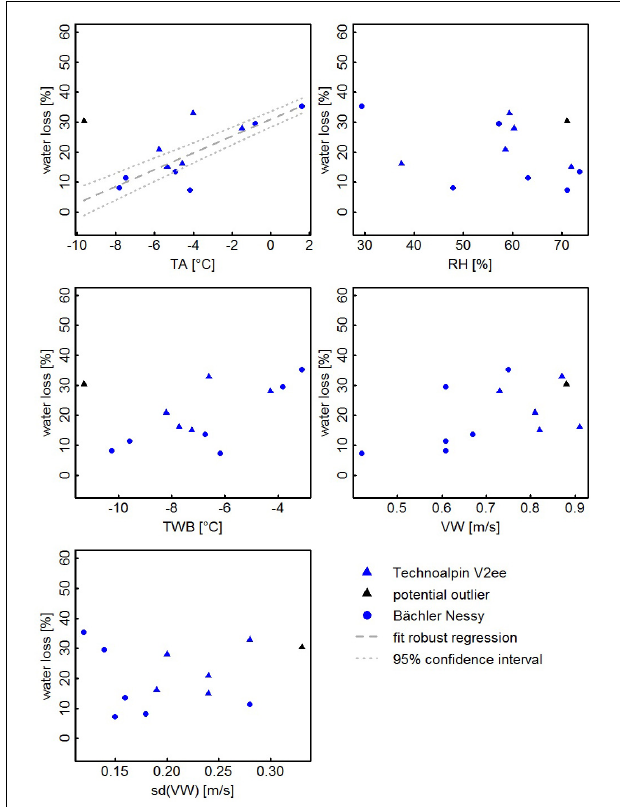
FIGURE 6 | Scatterplots of calculated water losses vs. meteorological properties measured at the weather station. The potential outlier is the experiment of February 25,